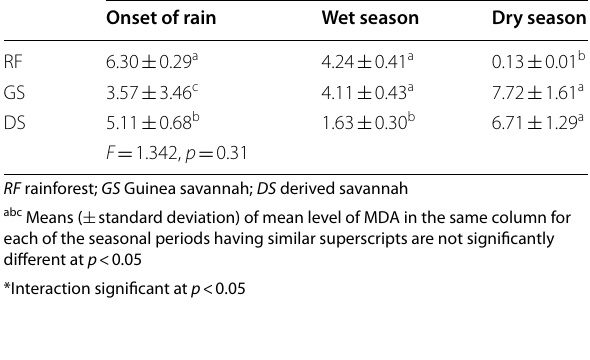
Table 4 Level of lipid peroxidation (Malondialdehyde [MDA] (U/g 10 –5 )) of the honeybees from three ecological zones of × Nigeria